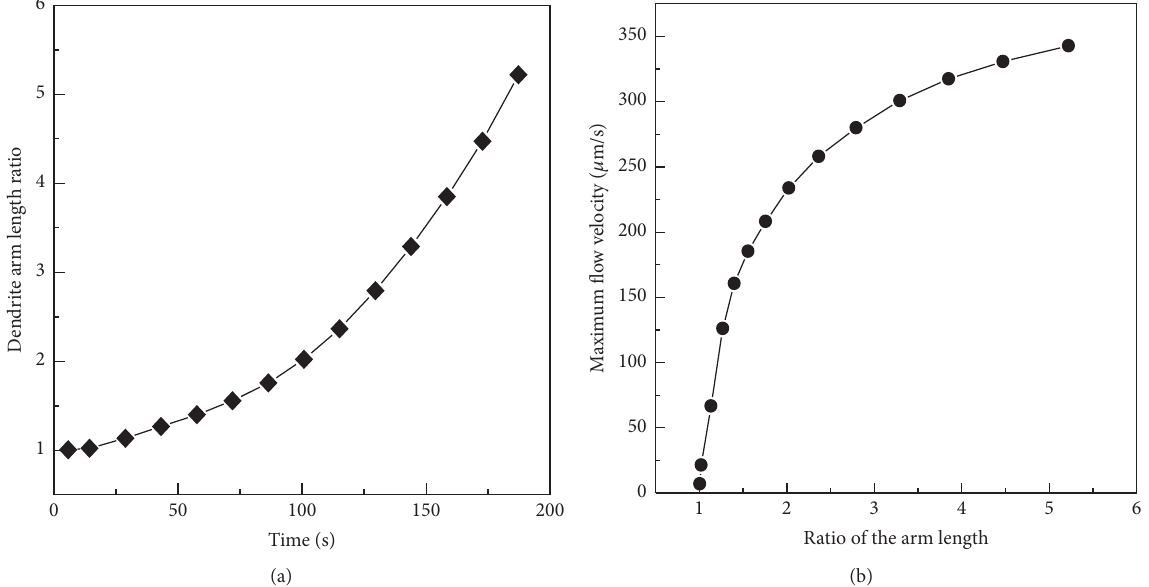
Figure 4: The growing dendrite leading to the increment of natural convection which in turn results in the asymmetry of the dendrite shape. (a) The variation of dendrite arm length ratio with time. (b) The relationship between the maximum flow strength and the dendrite arm length ratio.